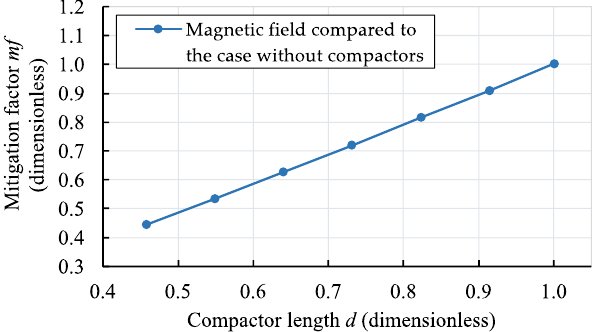
Figure 8. Direct dependence between relative insulators length and field mitigation (the magnetic induction is analyzed at the span center, 1 m above the ground level).